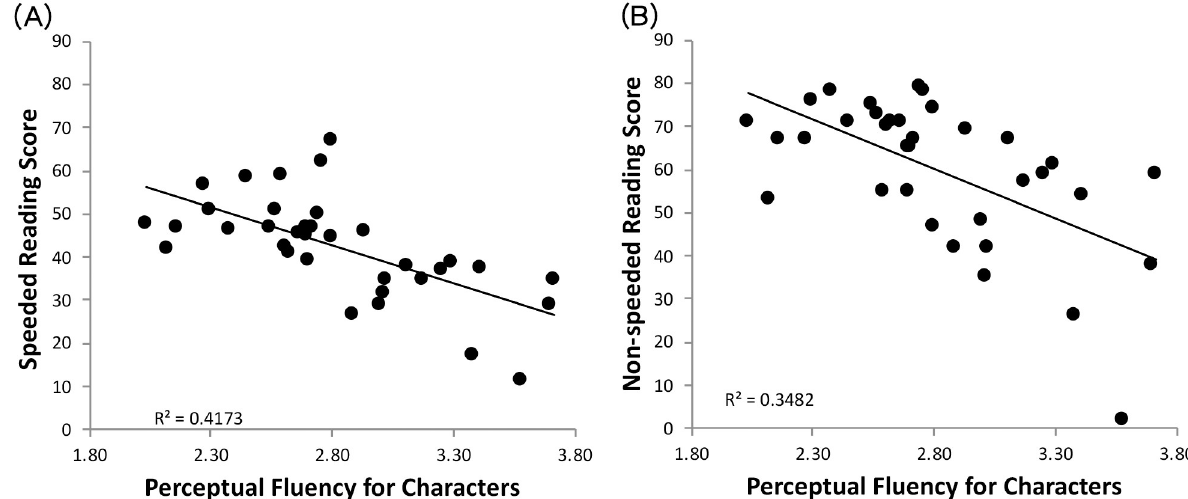
Fig 2. Scatterplots of the scores of (A) speeded reading and (B) non-speeded reading against perceptual fluency for characters in log duration.